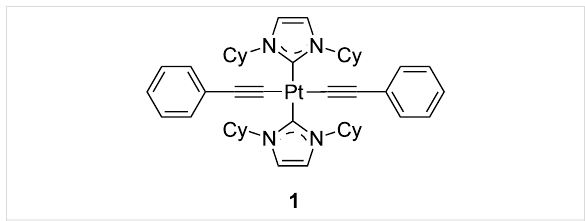
Figure 1: Molecular structure of neutral platinum(II) complex 1 bear- ing four monodentate ligands; cy = cyclohexyl [19].